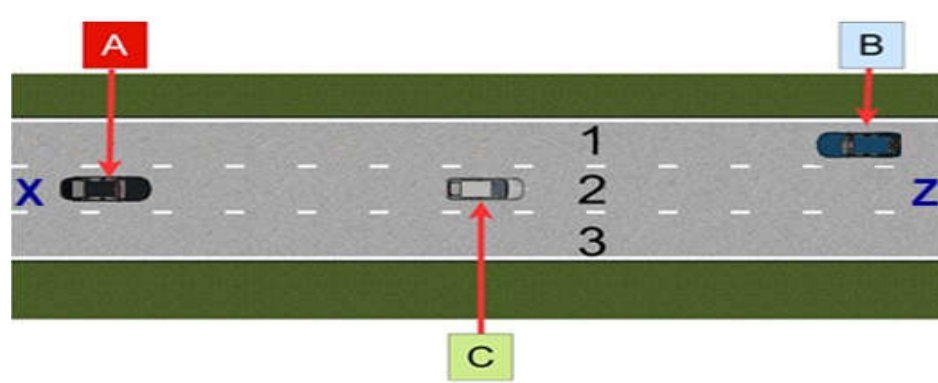
Figure 4. OMS with vehicles located in the left lane (1) and in the center lane (2).